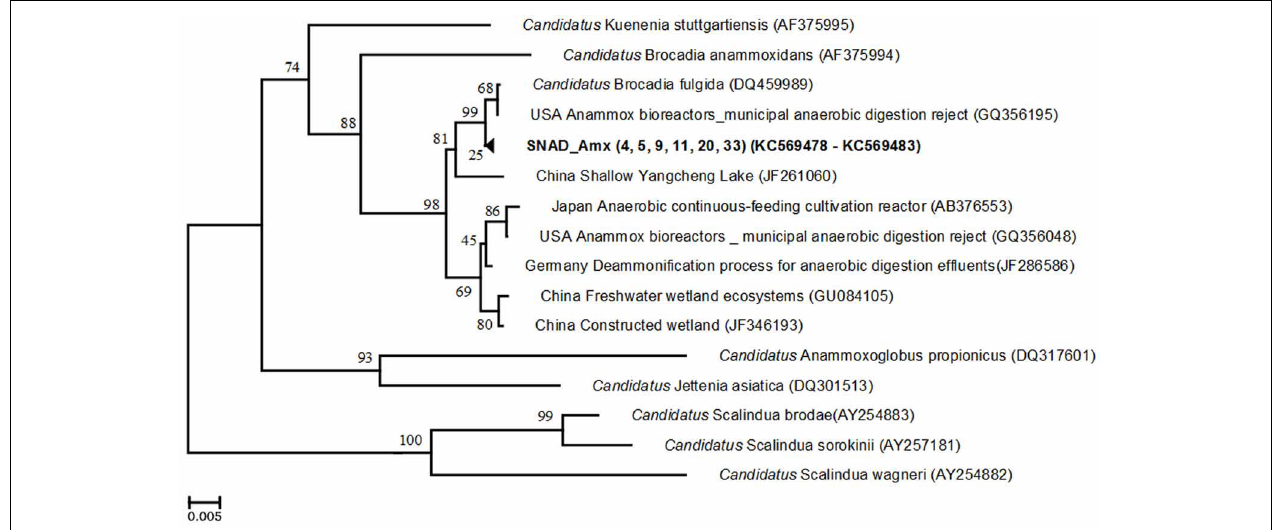
FIGURE 3 | Phylogenetic tree, based on 16S rRNA gene sequences using anammox-specific primers. The tree shows the phylogenetic position of the clone sequences within the anammox bacterial genera. The clone sequences are in bold. Names of anammox species are printed in italics. The phylogenetic tree was constructed using the Neighbour—Joining method